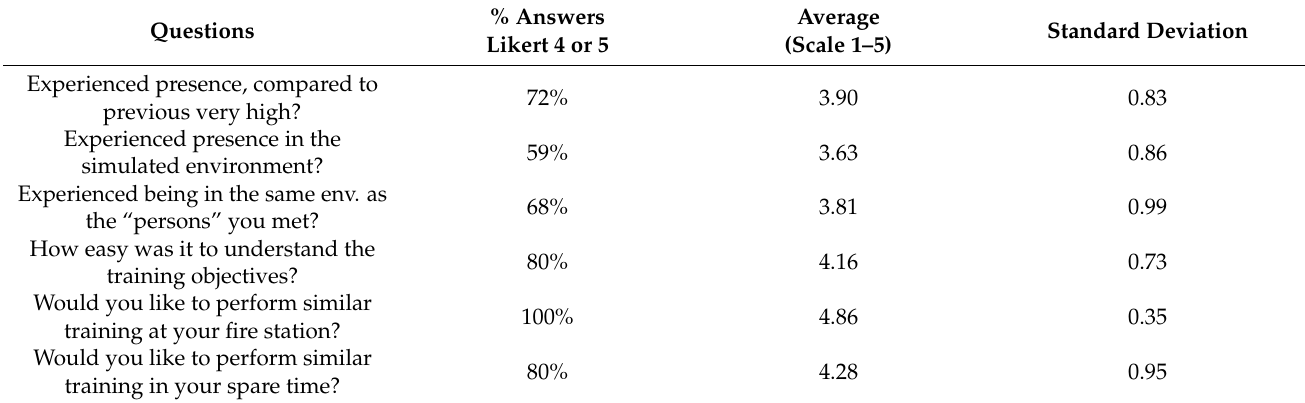
Table 1. Students’ response ( n = 90) to VS training on-site, excerpt from [66]. Answers in Likert scale, 1 (low) to 5 (very